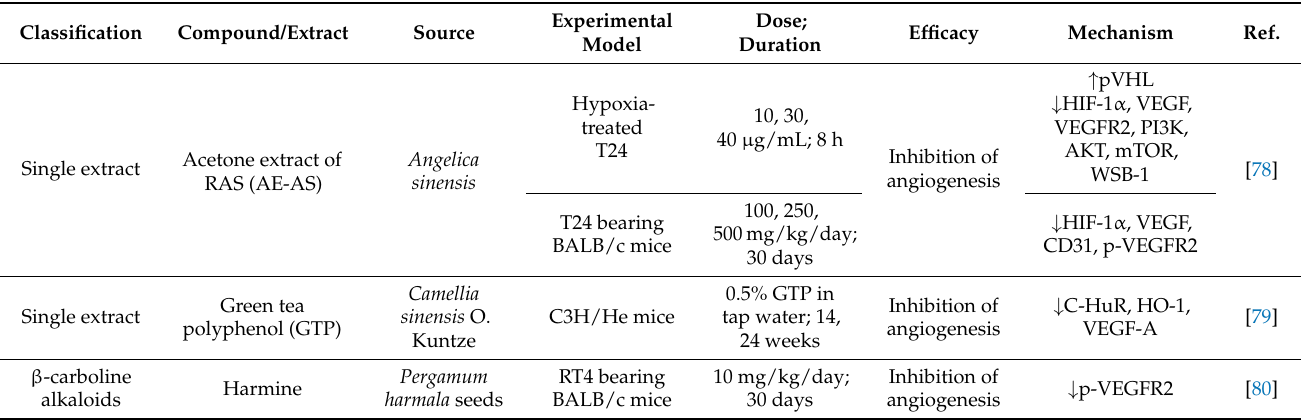
Figure 5. Chemical structure of compound inhibiting angiogenesis. Table 5. Natural Products inhibiting